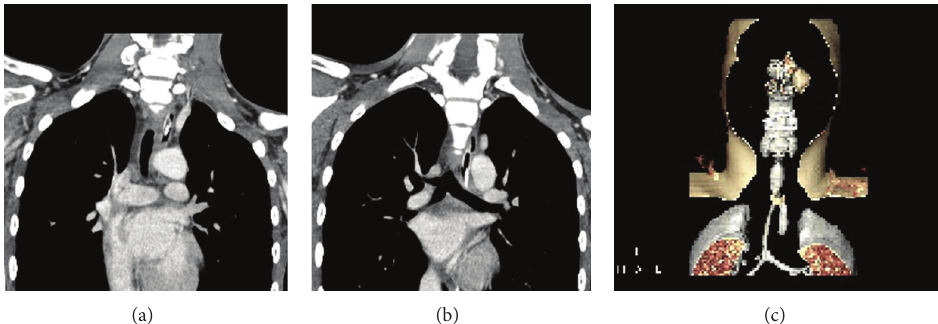
Figure 1: Initial CT of airway in coronal view with narrowed tracheal lumen of 1cm (a) and congenital loss of right main bronchus (b), reconstructed in 3D (c).